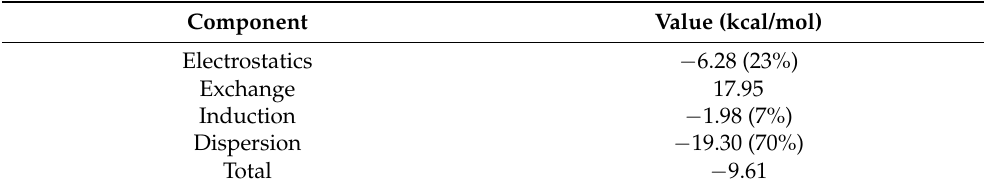
Figure 8. The optimized structure and RDG diagram (isovalue = 0.5) of [6, 6]CNB dimer. The ad- sorption surface corresponds to the value surface of the 𝑠𝑖𝑔𝑛(cid:4666)𝜆 (cid:2870) (cid:4667)𝜌 function mapped to the inter- action, in a.u.